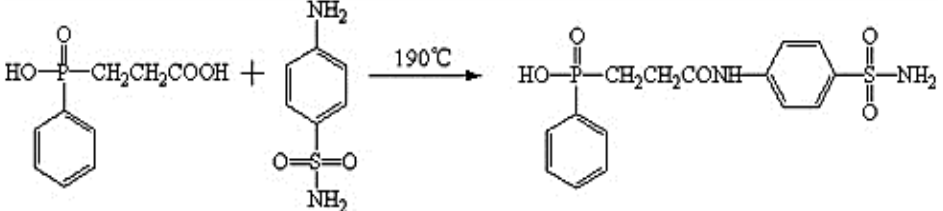
Figure 3. Chemical reaction of flame retardant synthesis of composites. Reproduced with copyright permission from Zhao et al. [73], Elsevier.